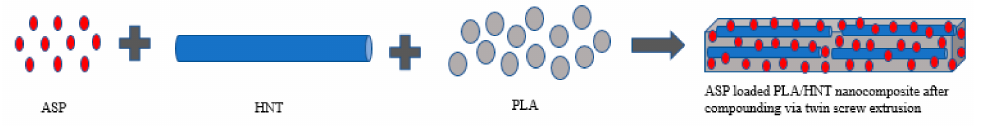
Figure 1. Schematic illustration PLA / (HNTs / ASP) nanocomposite by lumen-loading method for batch B1 and B5.